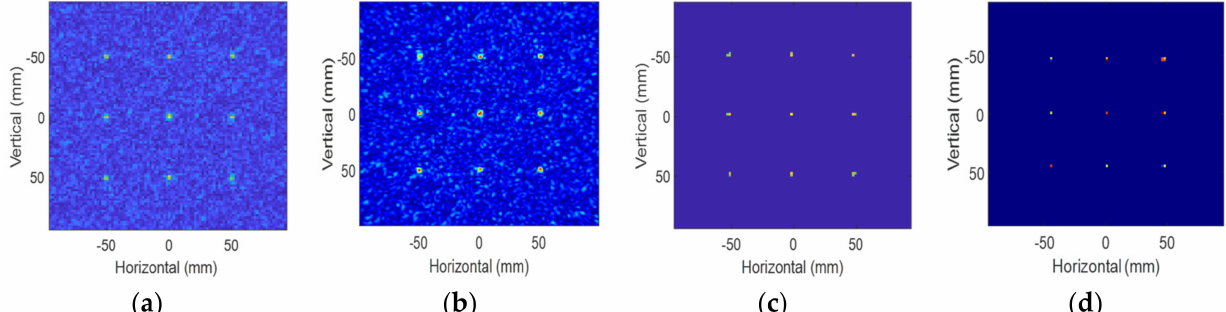
Figure 5. Spatial target model of multiple points in an ideal space. ( a ) The 2D multiple-point imaging result of BPA. ( b ) The 2D multiple-point imaging result of NUFFT-RMA. ( c ) The 2D multiple-point imaging result of OMP. ( d ) The 2D multiple-point imaging result of the proposed